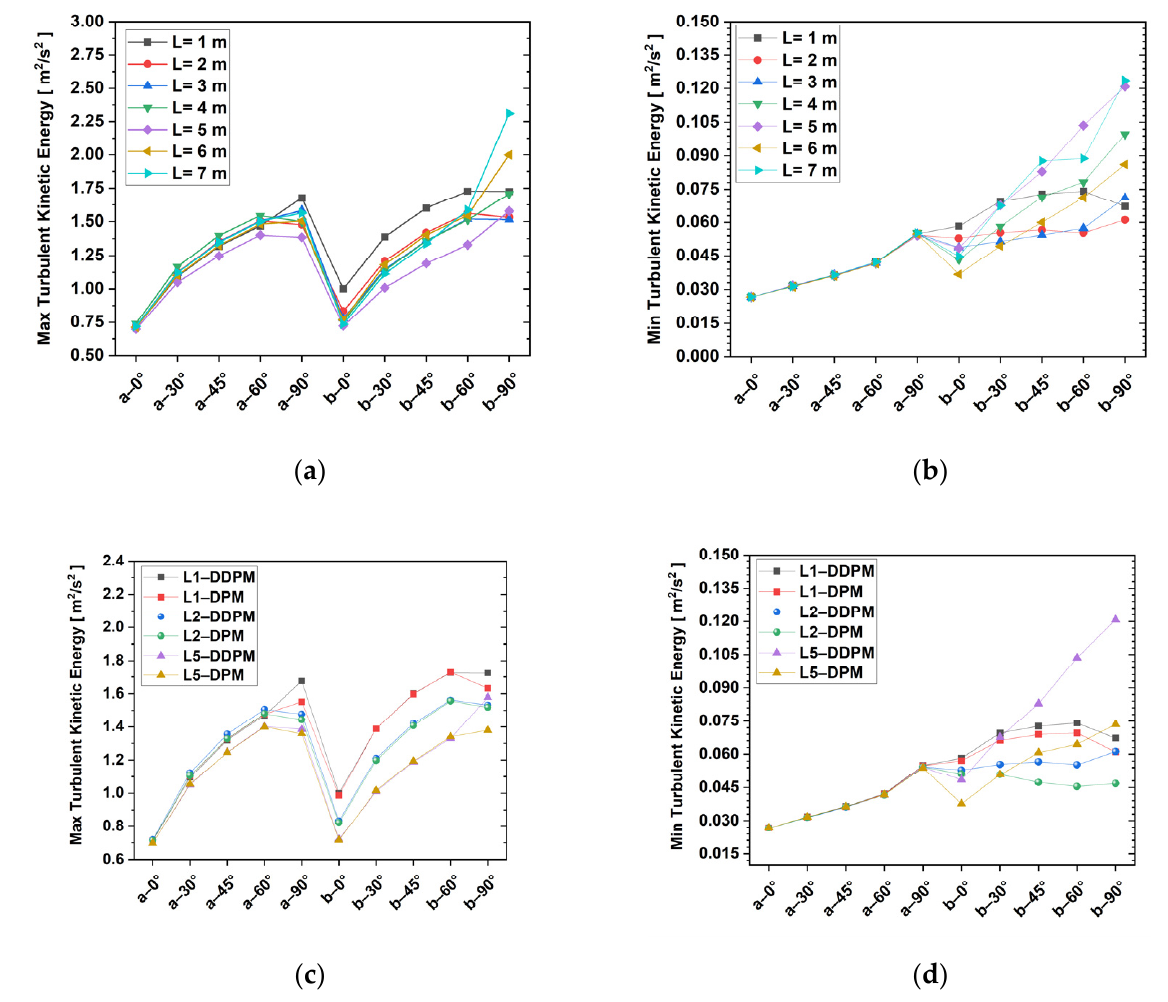
Figure 10. The turbulent kinetic energy varies with the location of different iso-surfaces: ( a ) The maximum turbulent kinetic energy varies with the length of Straight-2; ( b ) The minimum turbulent kinetic energy varies with the length of Straight-2; ( c ) Comparison of the maximum turbulent kinetic energy obtained by the two models; ( d ) Comparison of the minimum turbulent kinetic energy obtained by the two models.